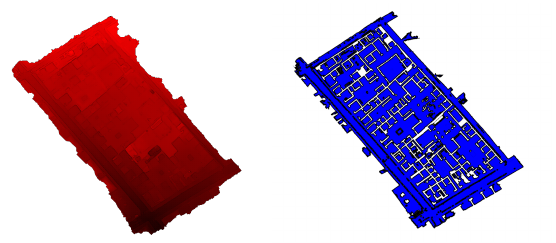
Figure 5: The height and collision maps for the Pompei example tions of the geometry via Poisson reconstruction, and encoding the height from the ground in the red channel using a per-vertex color function of MeshLab tool (see Figure 5,left). Some exam- ples of the navigation of the Pompei dataset are shown in Figures 2 and 3. In this case, the green channel of the image map was used to link the 3D model to an already existing website that con- tained the documentation (text and images) for each single room of the Insula. By encoding in the green channel the Id of each room, it was possible to access directly from the navigation con- text the corresponding page on the Pompei Project website.